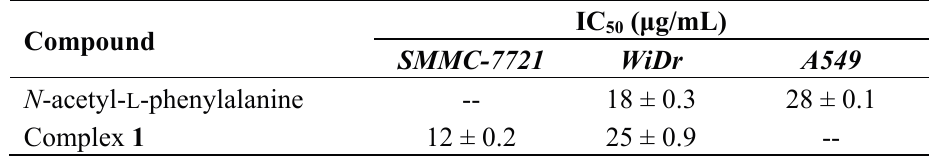
Table 1. Antitumor activities of complex 1 and N -acetyl- L -phenylalanine